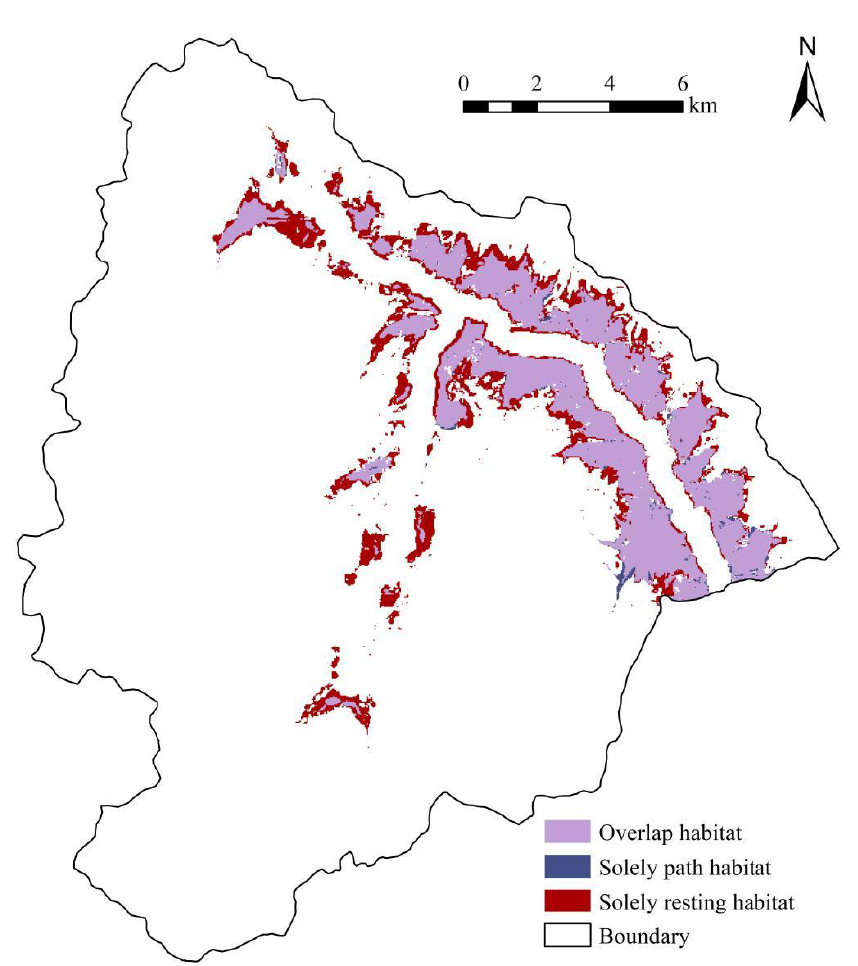
Figure 4. Overlap of suitable resting and path habitats in the Wanglang Nature Reserve.